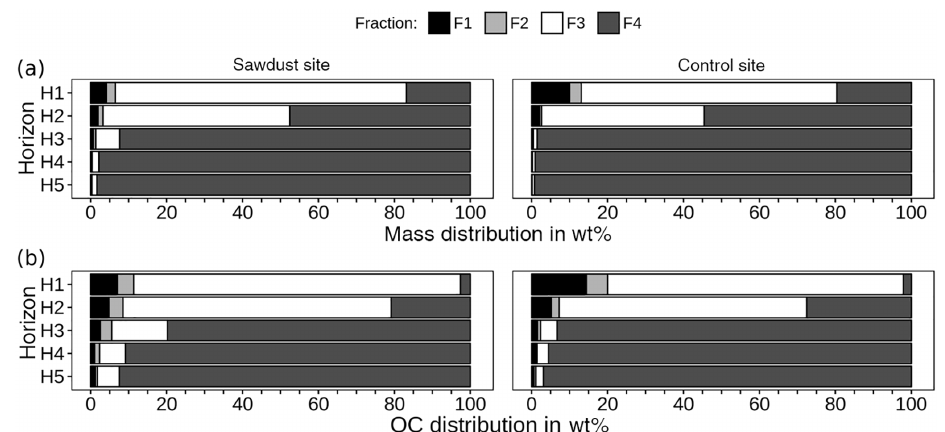
Figure 4. Mass (a) and organic carbon (OC, b ) distribution over density fractions, given as percentages of cumulated fractions. Fractions 1 and 2 contain material either directly released (F1) or after applying 300JmL − 1 sonication energy (F2). Fractions 3 and 4 comprise organic matter strongly bound to mineral phases in soil particles of densities between 1.6 and 2.0Gcm − 3 (F3) or >2.0gcm − 3 (F4).